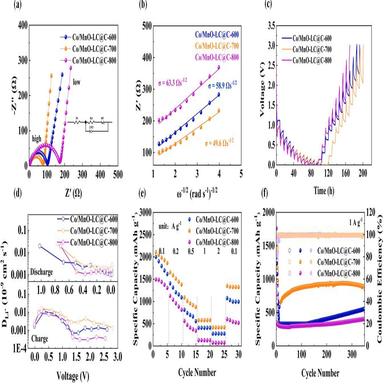
(a) Nyquist plots for Co/MnO-LC@C composites before cycling. (b) Correlation of Z' with ω− 1/2 in the low-frequency zone for Co/MnO-LC@C composites. (c) The GITT curves of Co/MnO-LC@C composites. (d) The corresponding Li+ diffusion coefficient of Co/MnO-LC@C composites. (e) Rate performance of full batteries at 0.1–2 A g− 1 . (f) Cycling performance of full batteries at 1 A g− 1 .